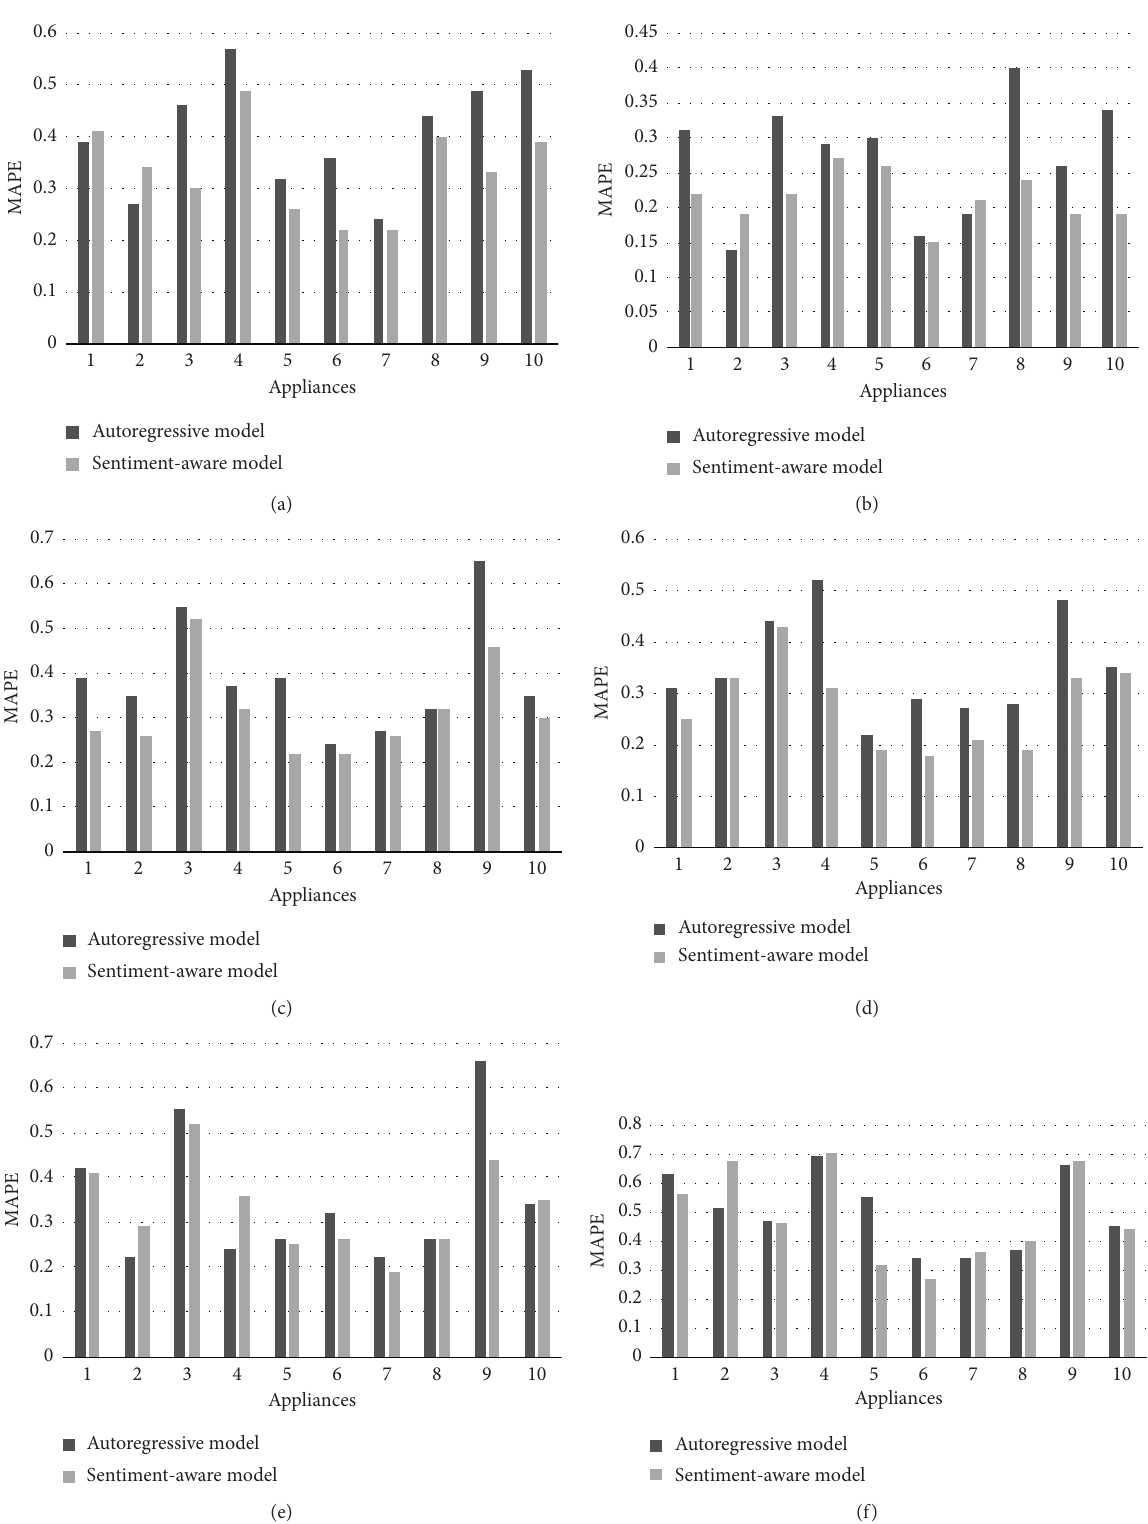
Figure 2: Experimental results of appliances sales forecast, (a) results of sales information one week ago, (b) results of sales information two weeks ago, (c) results of sales information three weeks ago, (d) results of sales information four weeks ago, (e) results of sales information five weeks ago, and (f) results of sales information six weeks